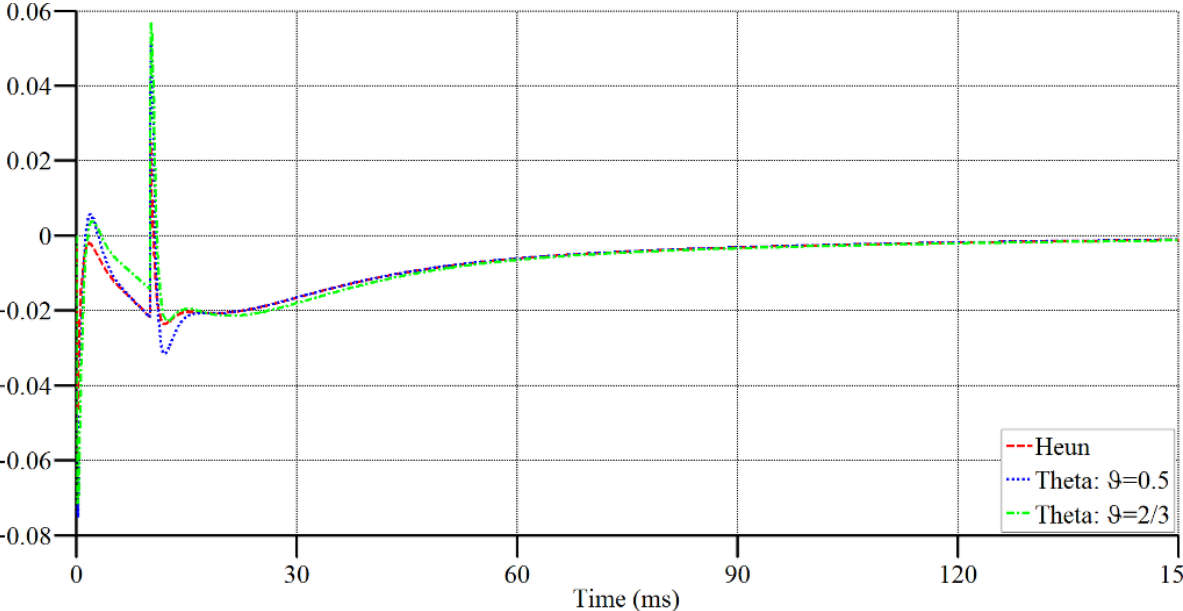
Figure 5. Capacitor voltage during the 0–0.8 ms time interval. Absolute errors of numerical solutions related to the Matlab Simulink solution are shown in Figures 6 and 7. Maximum values of these errors are presented numerically in